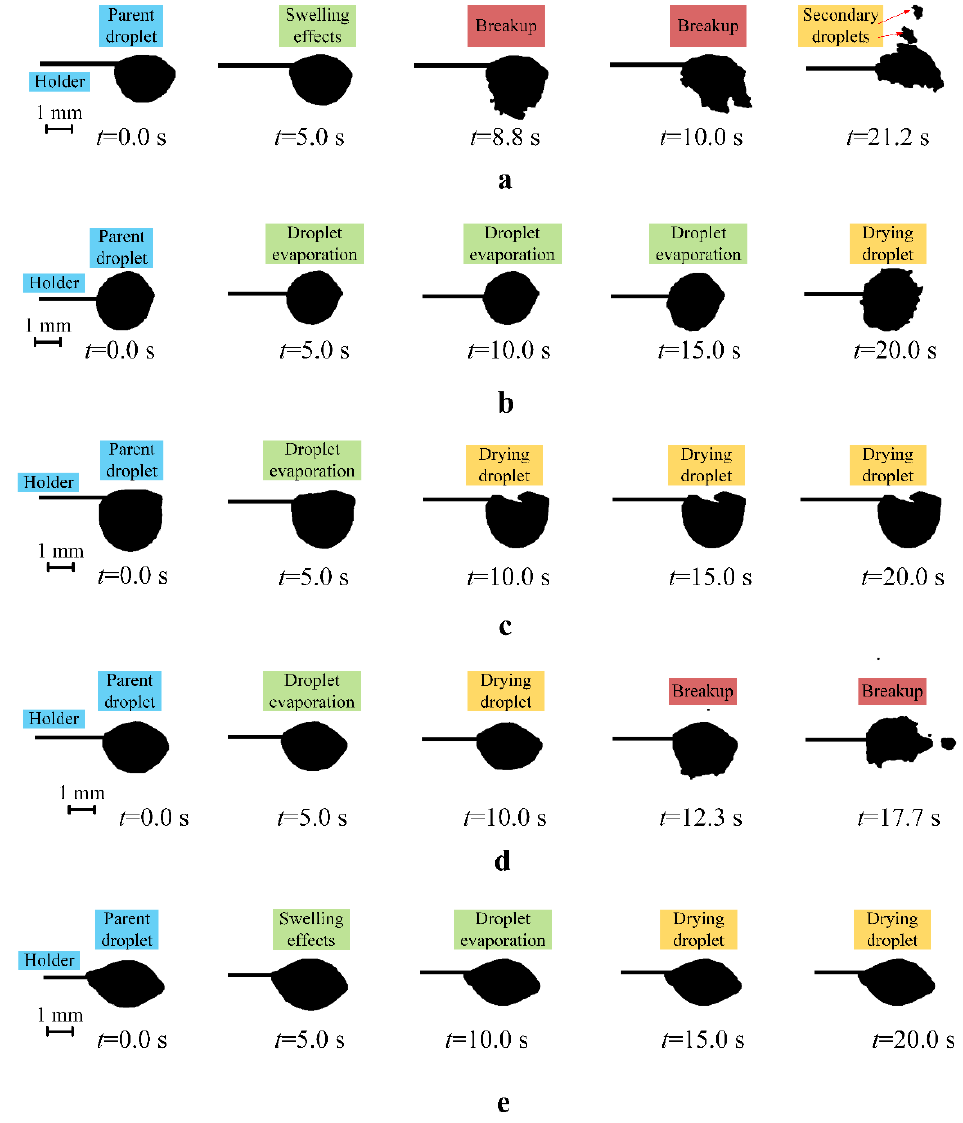
Figure 2. Images showing the evaporation, drying, and breakup of C50W49D1 ( a ), C50W49LE1 ( b ), C50W49LI1 ( c ), C50W49R1 ( d ), and C50W50 ( e ) at T a ≈ 450 K and R d0 ≈ 1.0 mm.